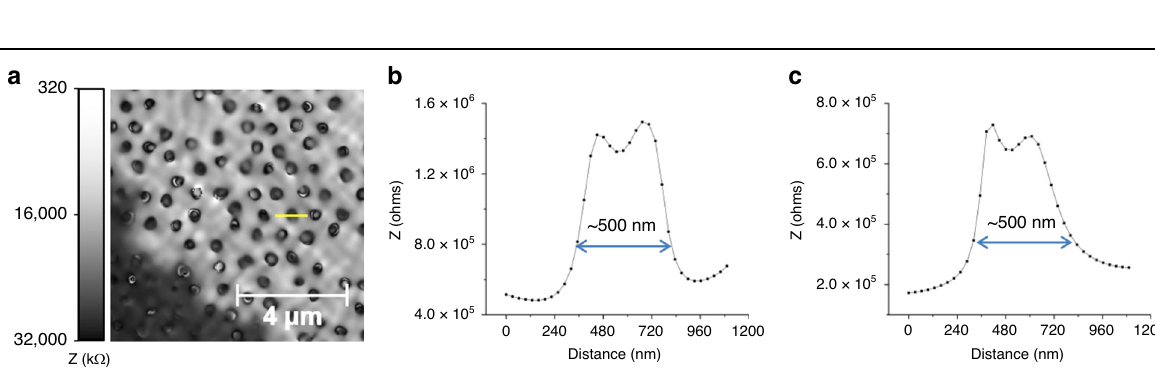
To quantitatively compare the frequency-dependent el- epi-MISS-derived data to the conventional EIS data (Fig. 4b), the macroscopic impedance of the same TiO electrode was measured by EIS between 0.2 and 1.6 Hz.